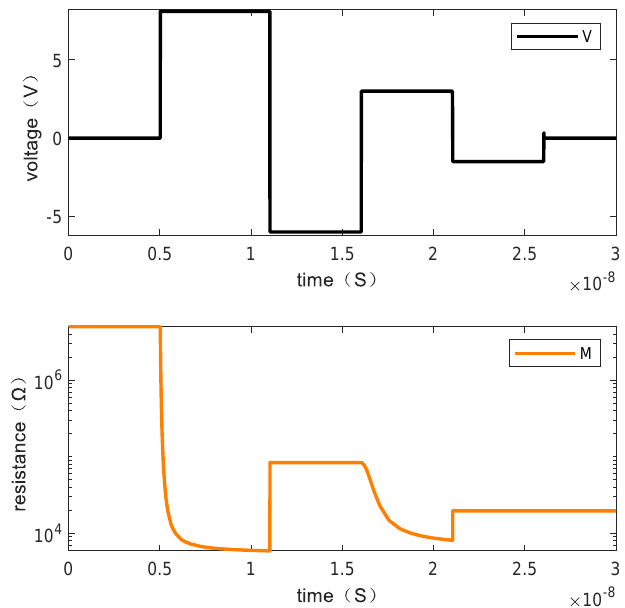
Figure 16. The changes of resistance value of the memory cell when writing “0101”.